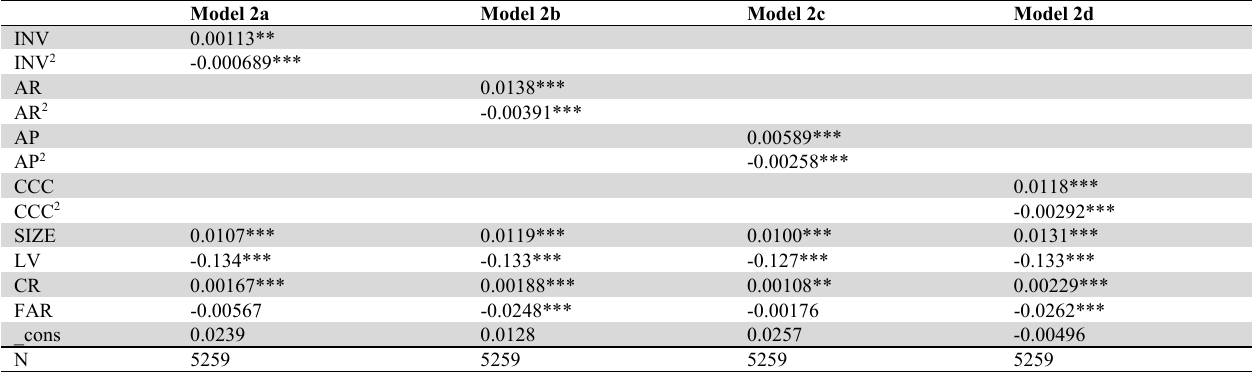
Regression results of Model 2